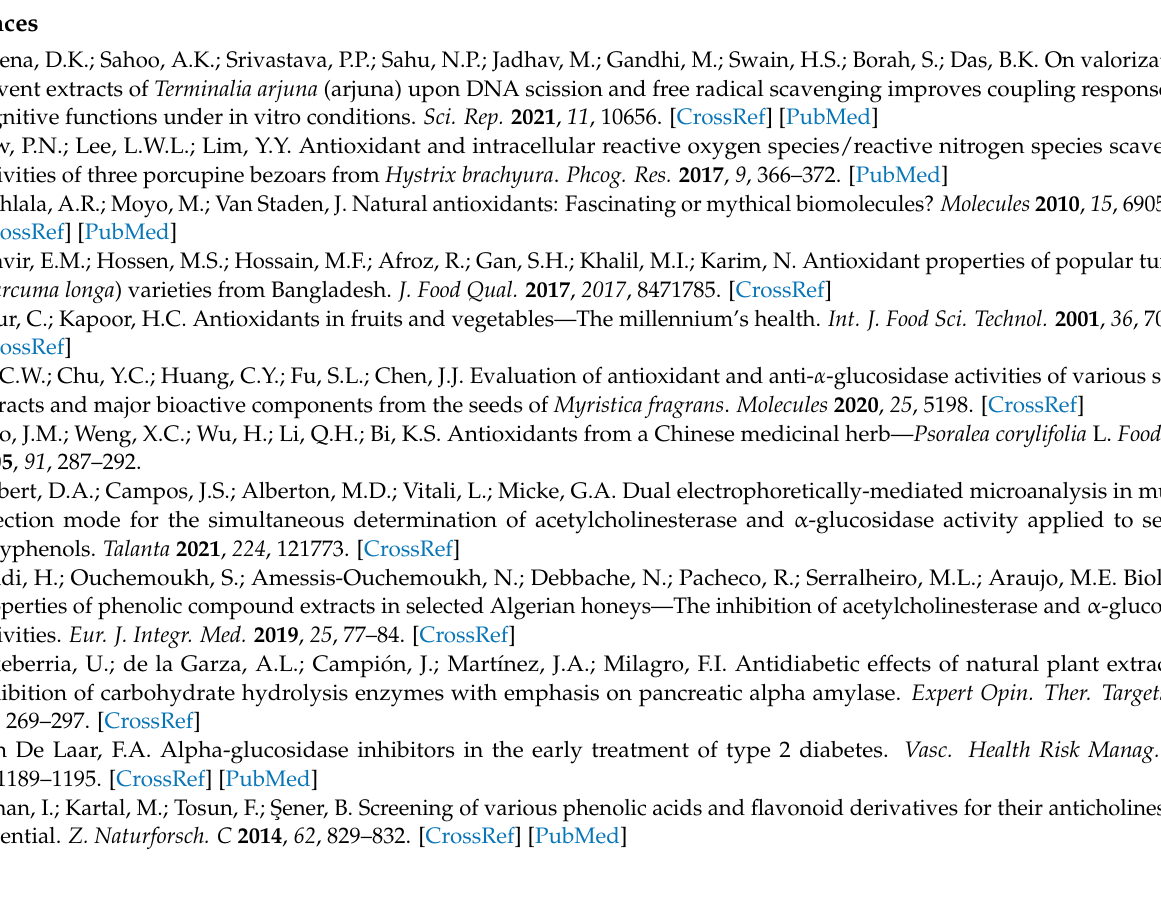
(methanol- d 4 , 500 MHz) of euscaphic acid ( 5 ). Figure S6: 1 H-NMR spectrum (acetone- d 6 , 400 MHz) of resveratrol ( 6 ). Figure S7: 1 H-NMR spectrum (methanol- d 4 , 400 MHz) of epicatechin ( 7 ). Figure S8: Reversed-phase HPLC chromatogram of isolated pure compounds. Figure S9: Reversed-phase HPLC chromatogram of water extract. Figure S10: Reversed-phase HPLC chromatogram of methanol extract. Figure S11: Reversed-phase HPLC chromatogram of ethanol extract. Figure S12: Reversed- phase HPLC chromatogram of acetone extract. Figure S13: Reversed-phase HPLC chromatogram of ethyl acetate extract. Figure S14: Reversed-phase HPLC chromatogram of dichloromethane extract. Figure S15: Reversed-phase HPLC chromatogram of chloroform extract. Figure S16: Reversed-phase HPLC chromatogram of n -hexane extract. Figure S17: Reversed-phase HPLC chromatogram of all solvent extracts with the same